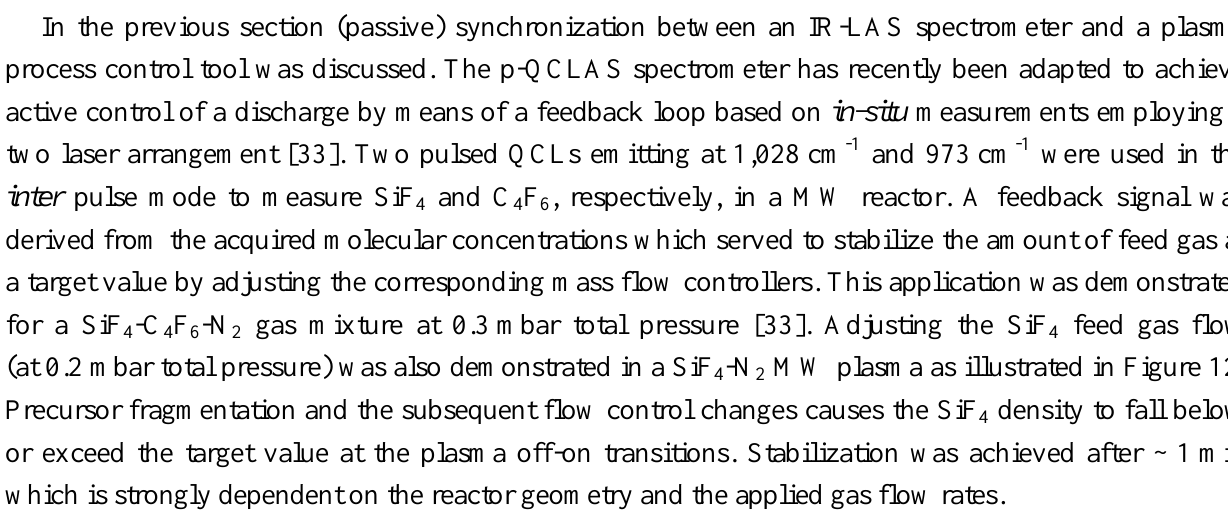
density (solid) around the target value of 4 -N MW plasma (0.2 mbar) by actively controlling 4 2